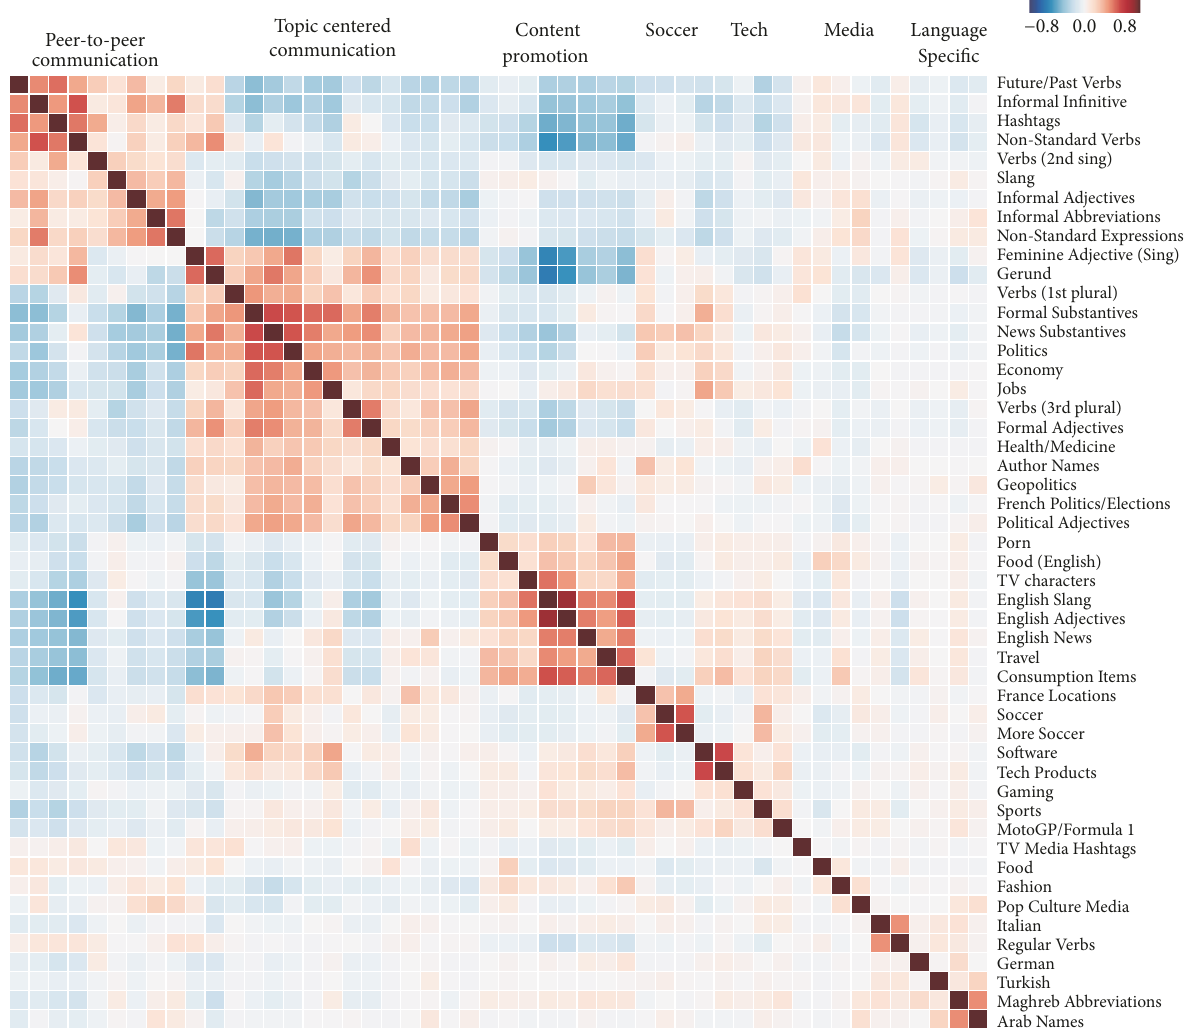
Figure 7: Clustered topic-to-topic correlation matrix: topics are generated via the spectral clustering of the word2vec word cosimilarity matrix.Rowlabelsarethenameoftopicswhilecolumnlabelsaretheircategories.Bluecells(resp.red)assignnegative(resp.positive)Pearson’s correlation